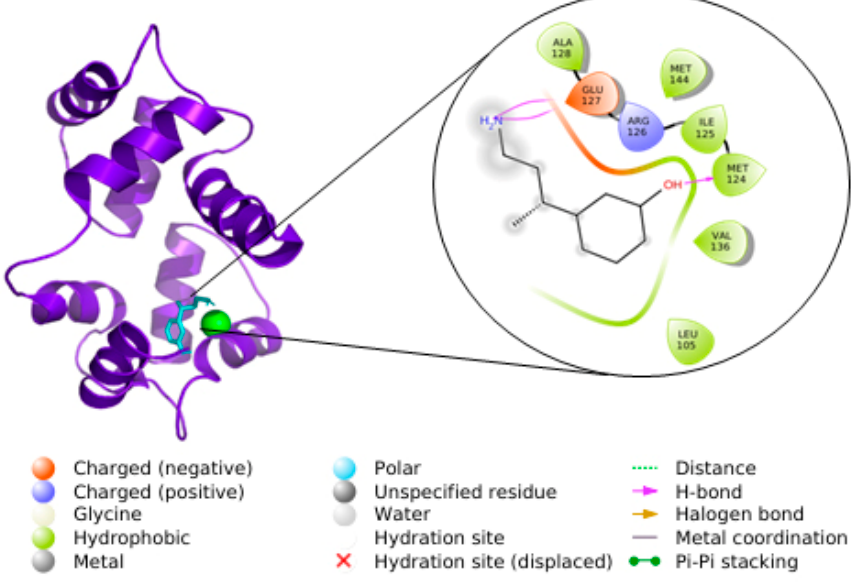
Figure 6. Docking of CaM–5-HT complex. CaM is shown in purple cartoons, position 124 in green spheres, and 5-HT in cyan stickers. The analysis of the interaction residues at 4 Å of 5-HT is shown in a zoom. The figures were made with PyMOL and Maestro.